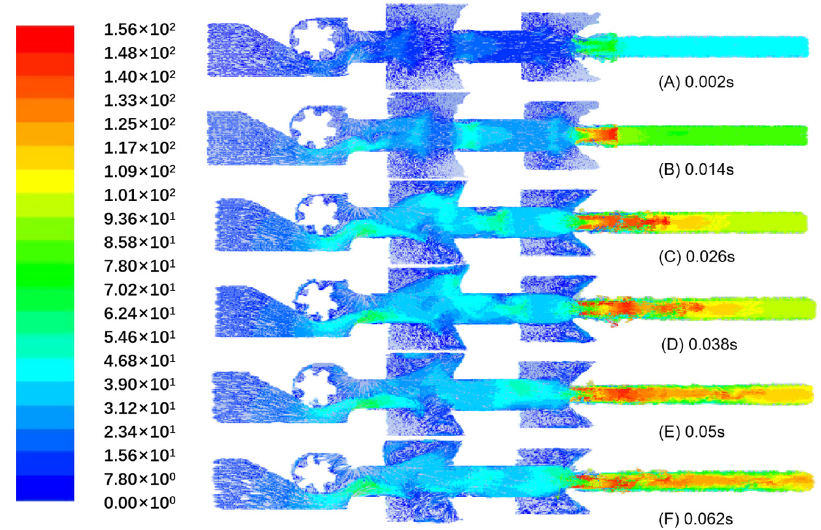
Figure 3. Structural model of the multi − source pulse − jet generator.